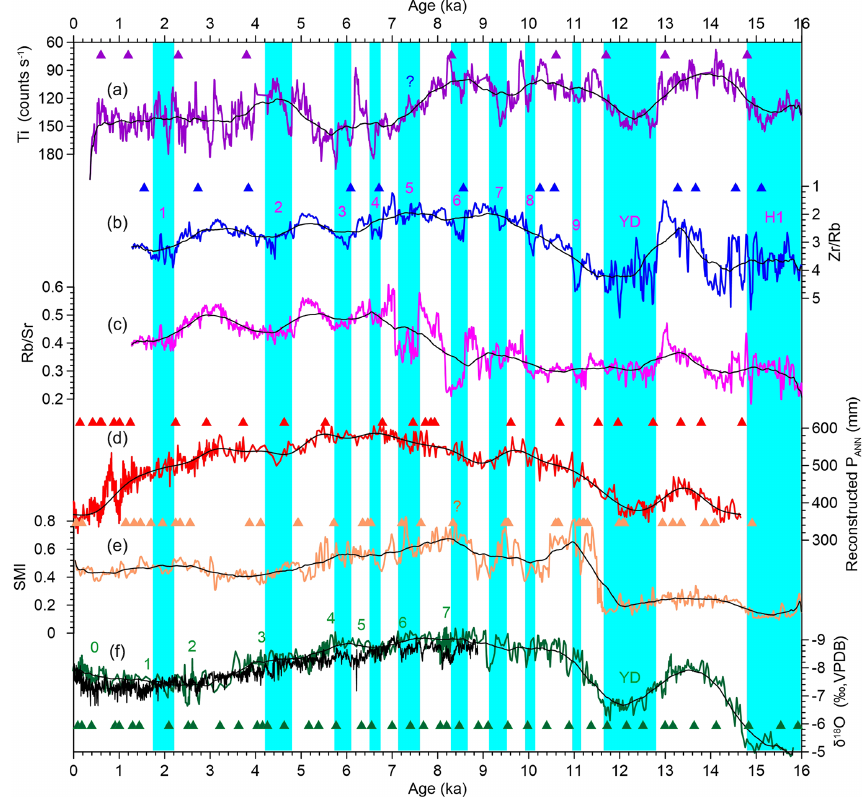
Figure 3. Comparisons of DDW records and other paleoclimatic records. (a) Ti content of Lake Huguang Maar (Yancheva et al., 2007); (b) Zr / Rb of DDW core; (c) Rb / Sr of DDW core; (d) pollen-based annual precipitation (PANN) reconstructed from Gonghai Lake (Chen et al., 2015); (e) Lake Qinghai summer monsoon index (SMI) (An et al., 2012); (f) speleothem δ 18 O from Dongge Cave (Dykoski et al., 2005; Wang et al., 2005). AMS 14 C ages are marked on the records of Lake Huguang Maar (purple triangle), DDW (blue triangle), Gonghai Lake (red triangle) and Lake Qinghai (peach triangle). The 230 Th ages (green triangle) are shown on the speleothem records. The cyan bars indicate the timing of abrupt monsoon events in different